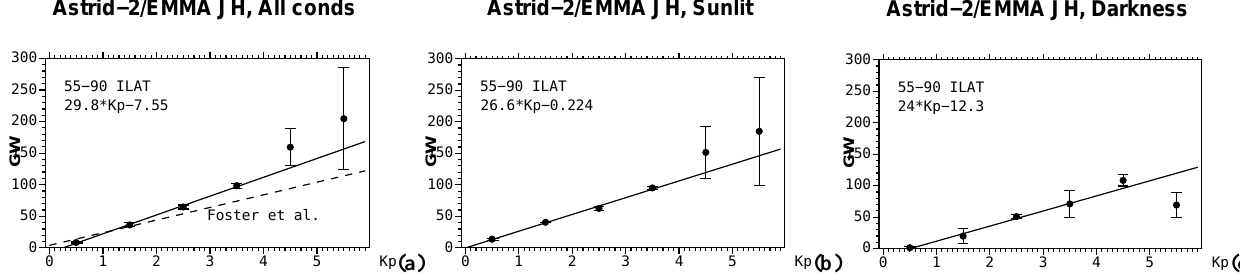
Fig. 5. The average Joule heating dependence on K p for ILAT 55–90, all MLT and for (a) all solar illumination conditions, (b) sunlit conditions and (c) darkness conditions. In each subplot, the solid line represents a fit to the data and the corresponding formula is also shown (see also Table 1, row 4–6). The error bars correspond to partitioning the data set randomly into two halves and computing the value separately for each. The Joule heating is for all K p somewhat higher during sunlit conditions. In subplot (a) comparisons with the results of Foster et al. (1983) give that the Astrid-2/EMMA study indicates higher estimates of the Joule heating for K p > 2.